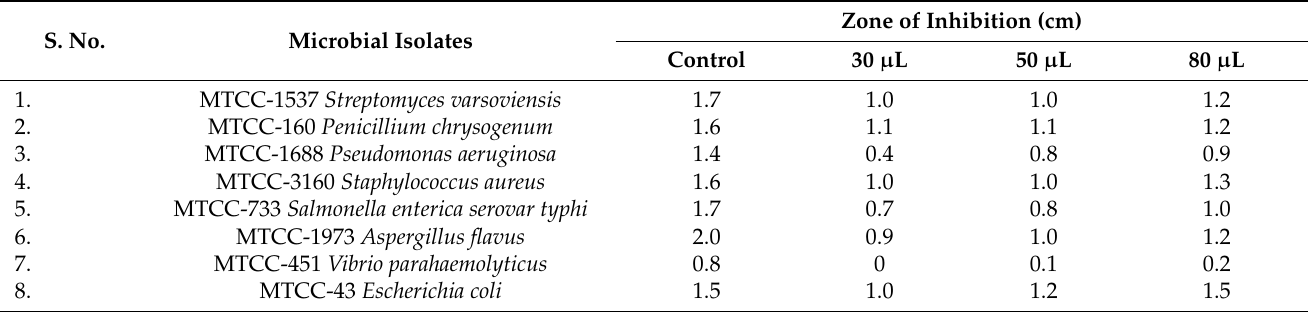
Table 4. Antimicrobial activity of Pantoea stewartii (H2)-synthesized Ag